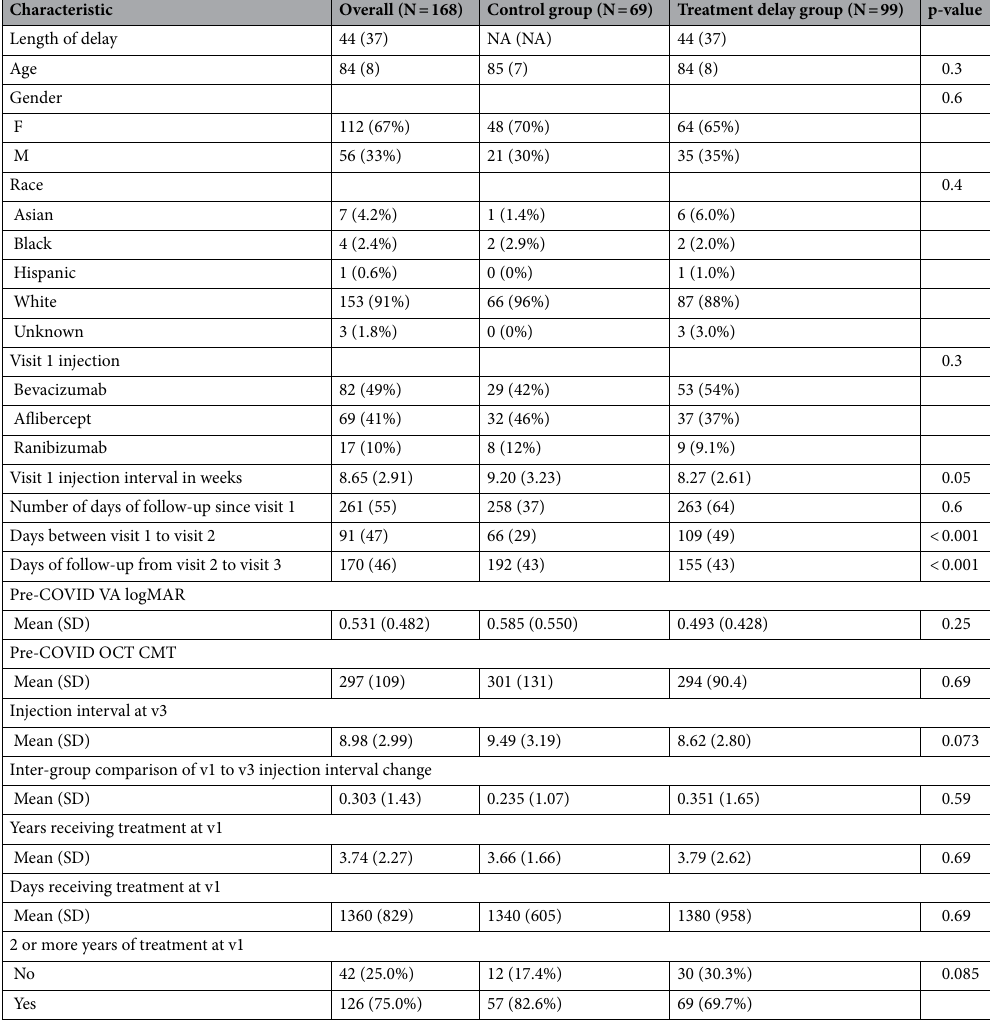
Table 1. Demographic